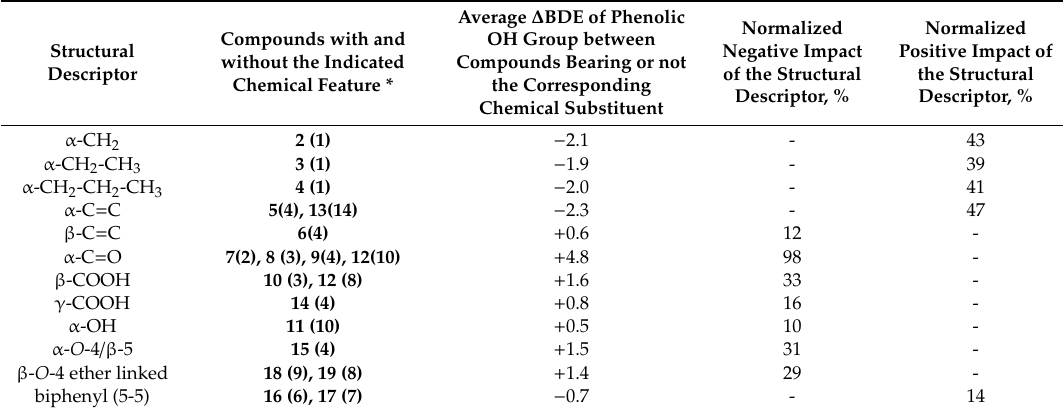
* model structures are depicted in Figure 1. Parent basic lignin structures are presented in